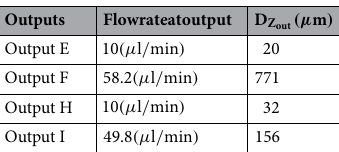
Table 2. Output parameters of the combinatorial microfluidic circuit.